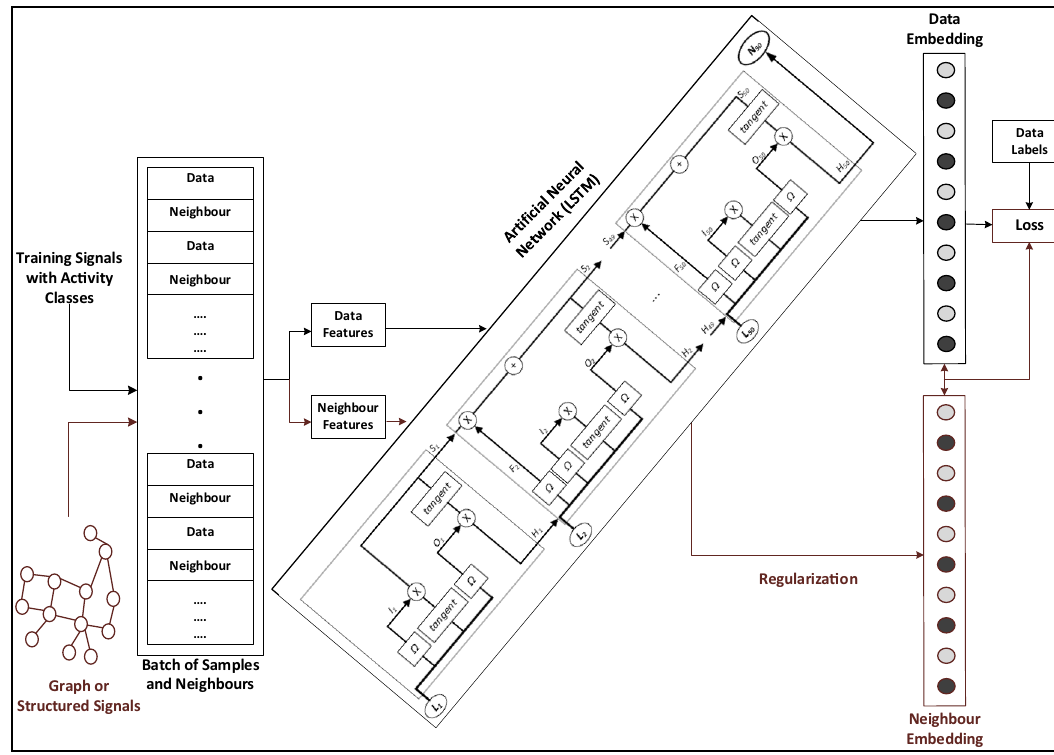
Figure 6. An LSTM-based neural structured learning model for human activities.